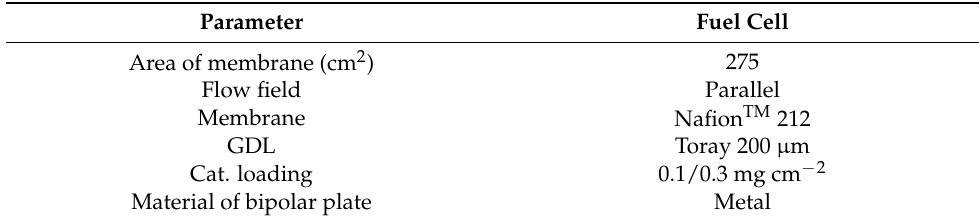
Table 4. Parameters of the single fuel cell.